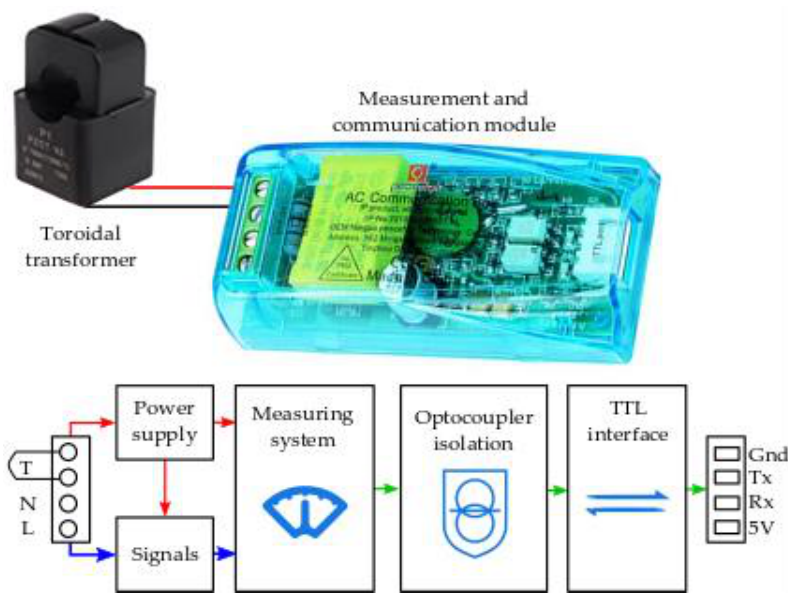
Figure 3. Alternating current measurement and communication device (PZEM-004T V3.0).